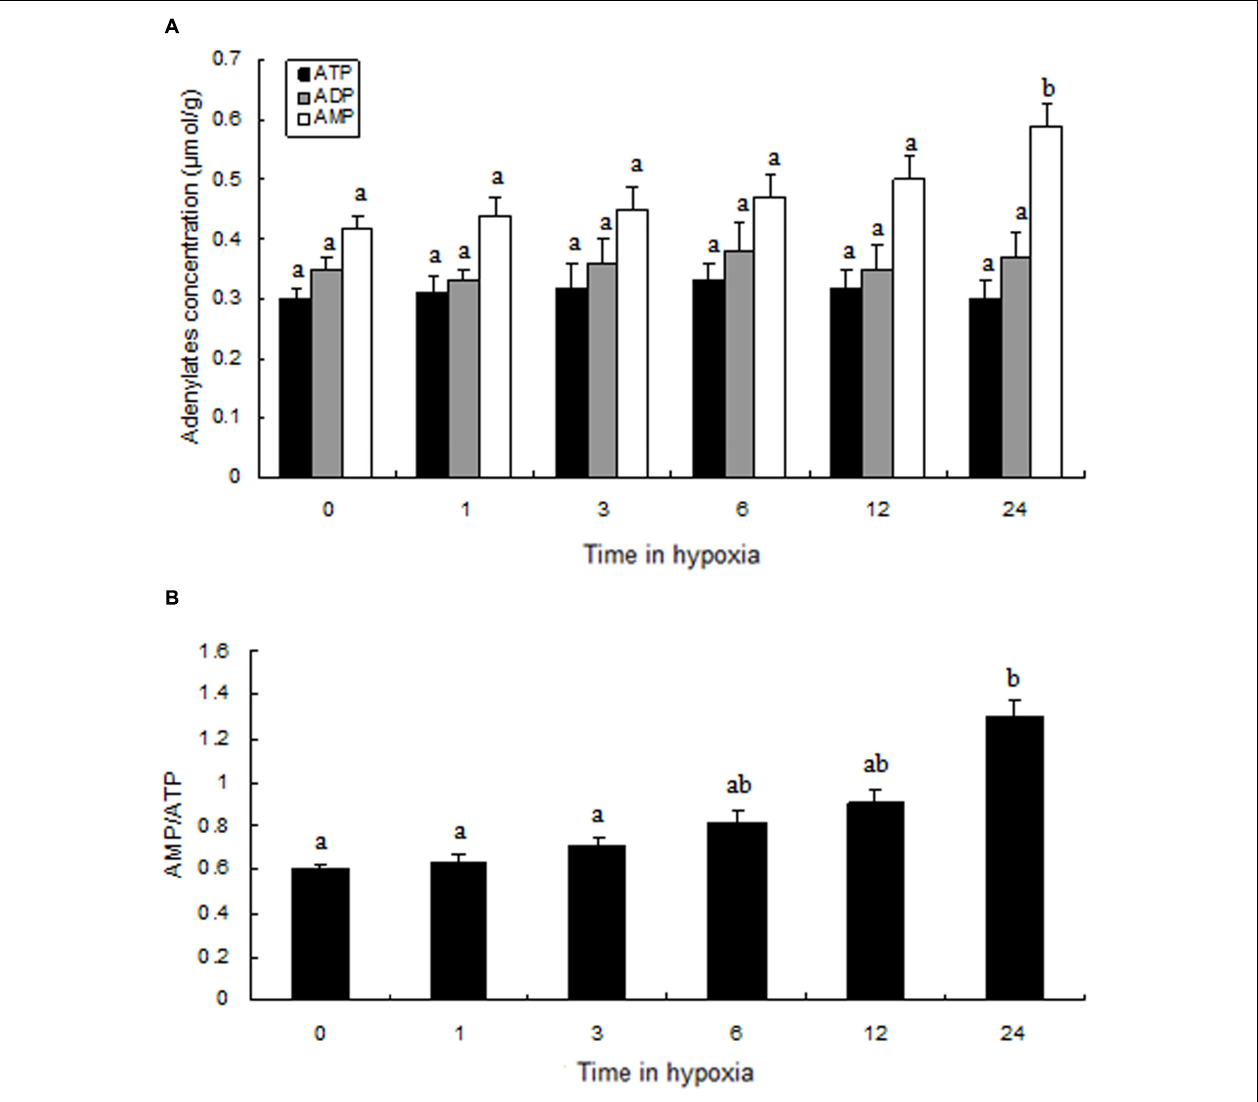
FIGURE 6 | Levels of adenylates in the muscle of prawns during hypoxia exposure. (A) Adenylate concentrations; (B) the ratio of AMP to ATP. Results are expressed as mean ± SE ( n = 9). Different letters indicate significant differences among all treatment groups ( P <